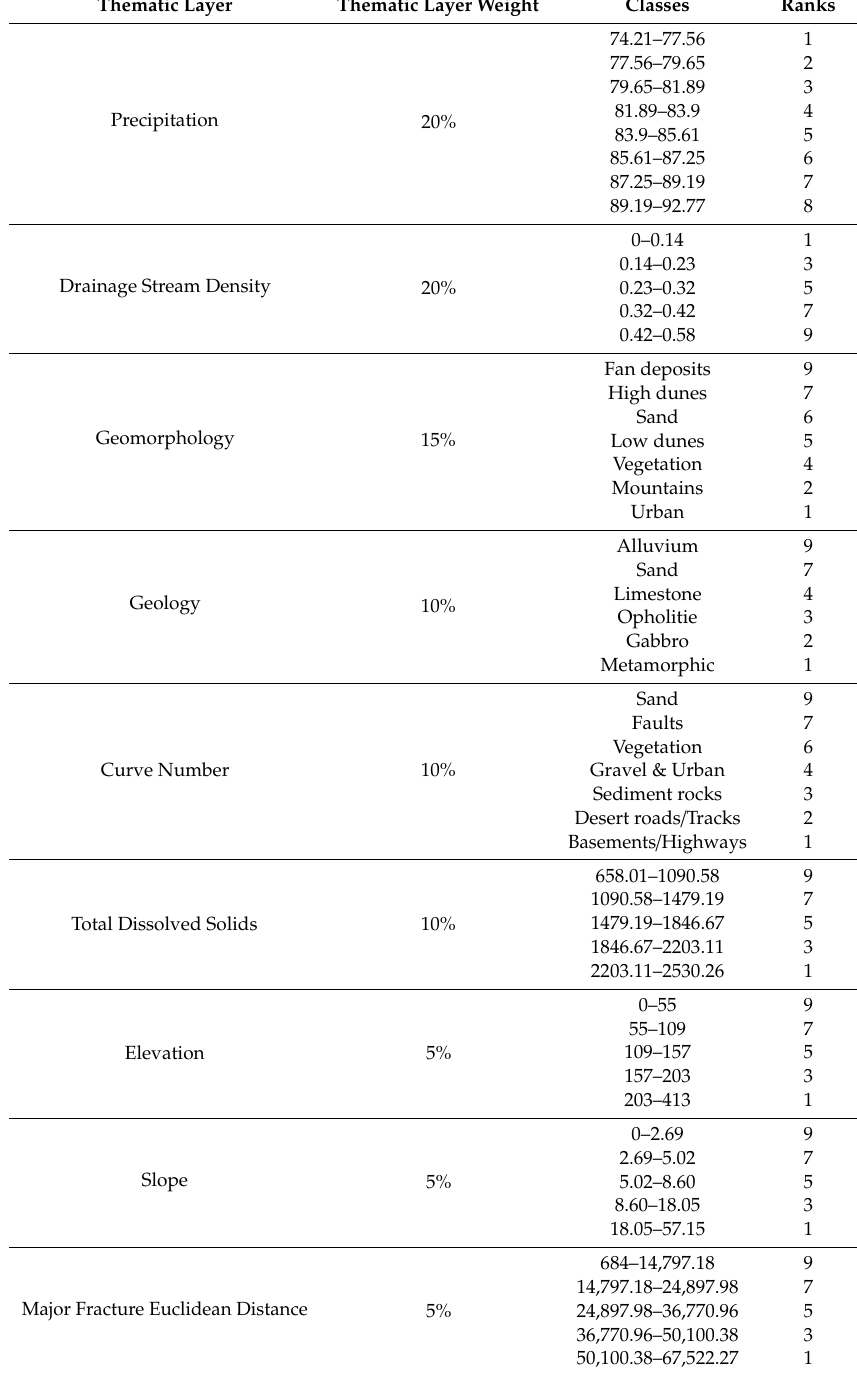
Table 2. Ranks and weights for thematic layers and their